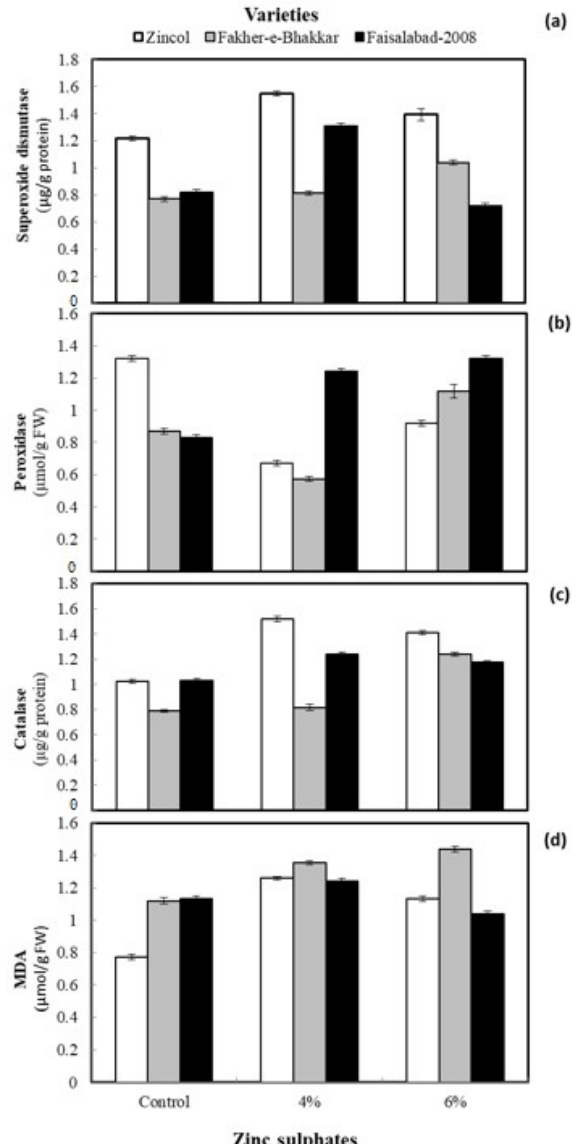
Figure 2. Interactive effect of varieties × zinc sulphates on the antioxidants of bread wheat grains grown under a semi ‐ arid environment. ( a )superoxide dismutase; ( b ) peroxidase; ( c ) catalase and ( d ) MDA. Error bars represent the standard error (n = 5).